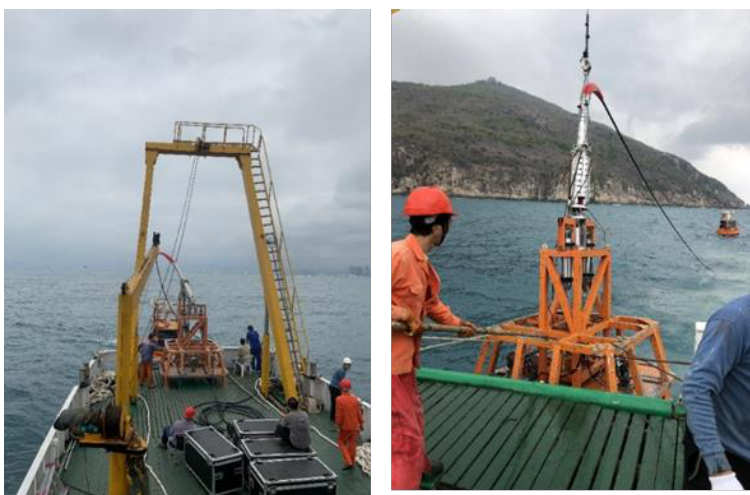
Figure 23. Launching the benthic node on the seabed.